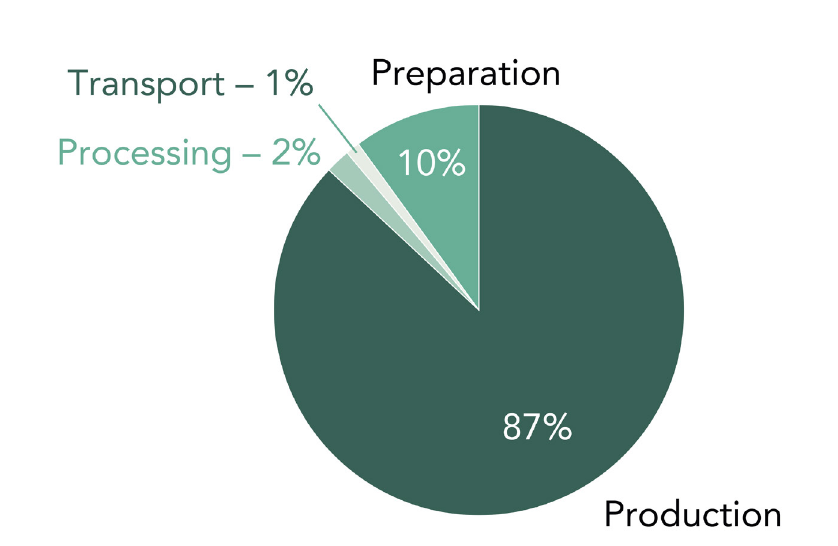
FIgure 18: Relative contribution of transport to food related greenhouse gas emissions in